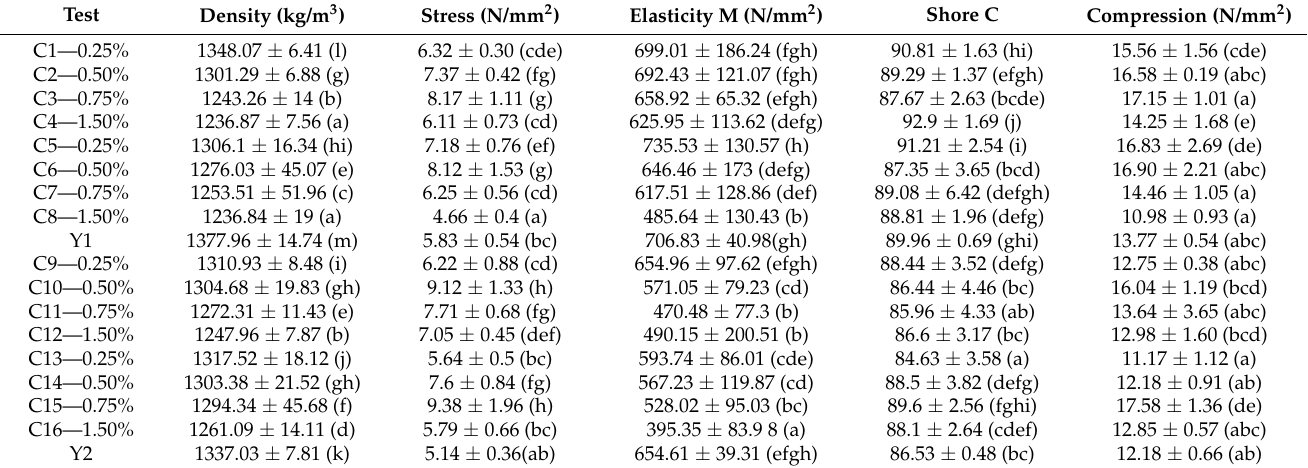
Table 7. Results of tests of elasticity, bending, hardness and compression of the